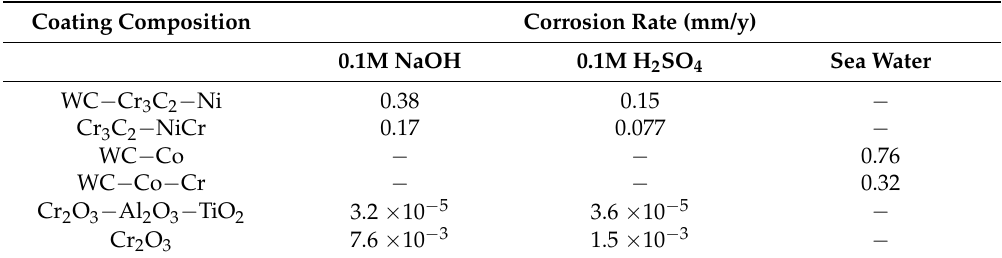
Table 2. Electrochemical corrosion measurements of different coating composition provided by HVOF [90]. Coating Composition